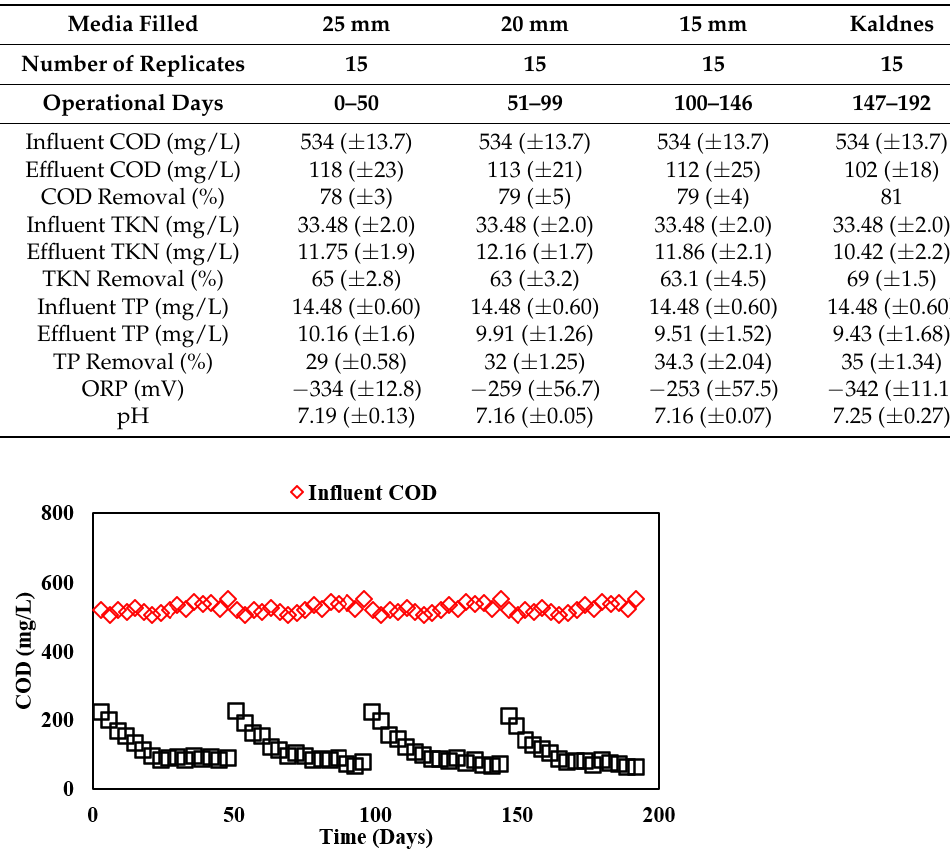
Figure 2. Influent and effluent COD concentrations in ABR-AF system during Phase II.